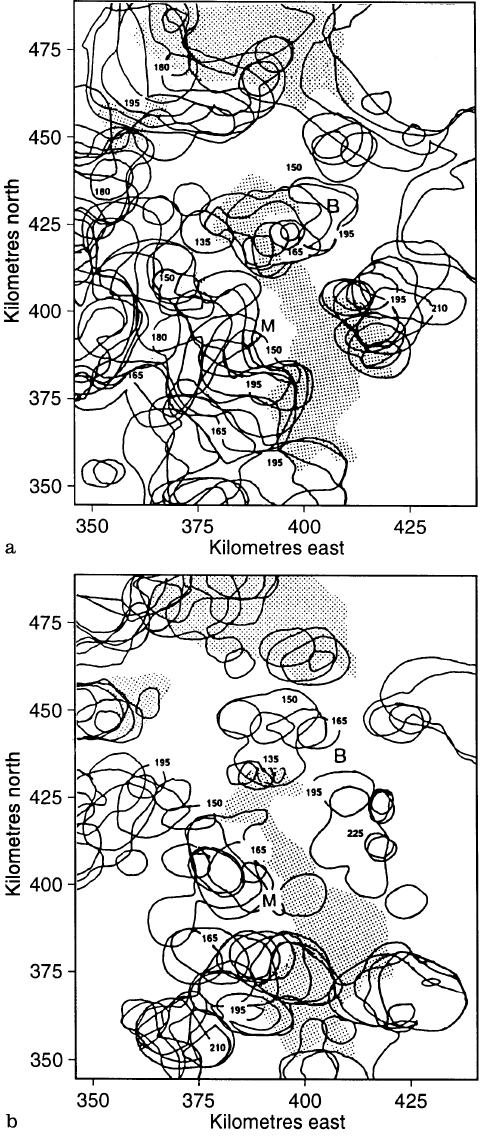
Fig. 9a, b. Overlay of the 0.0625 g/kg contours of rainwater mixing ratio (q (cid:82) ); elevations over 250 m are stippled . M and B refer to Manchester and Bradford/Leeds respectively. The numbers indicate the time in minutes of outbreak of cells for SET III a and SET IV b Table 1. Percentage (%) occurrence of individual cells with rainfalls higher than 10 mm/h during three different storm events that took place in the area of study in the week 19 — 25 May 1989 Time in